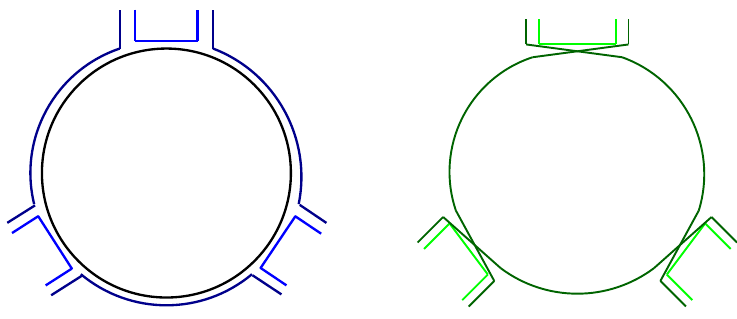
Figure 6 . Large- N counting in the blue (left) and green (right) parts for n = 3 . For the green part, a very similar analysis holds. An example is shown in figure 6.